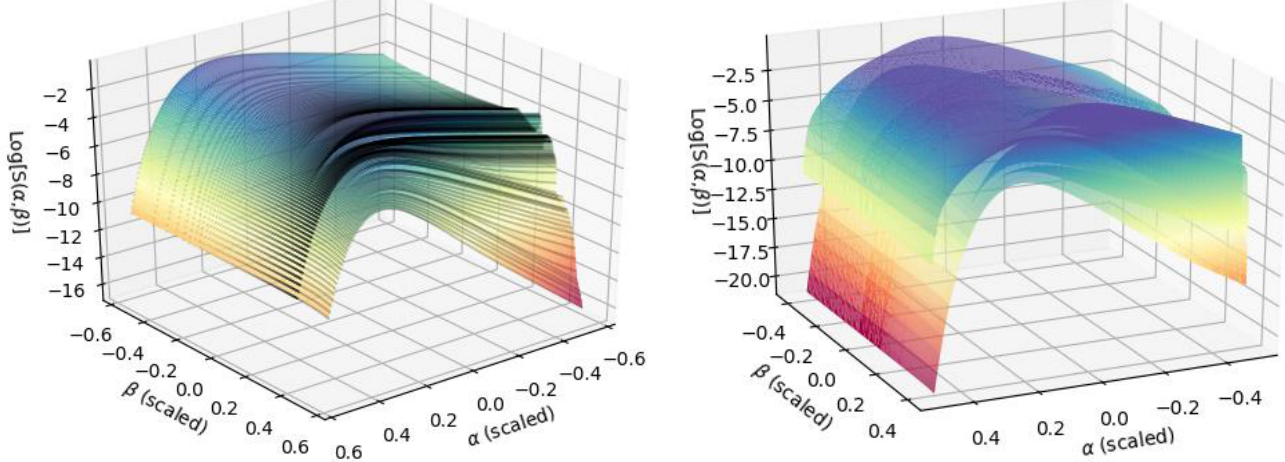
Figure 5. Representative 2-D (left, TSL v. (cid:10), (cid:11) for arbitrary (cid:12) against a test evaluation grid (black dots)) and 3-D (right, for 293 K (bottom surface) and 1293 K (top surface)) model predictions for Be in